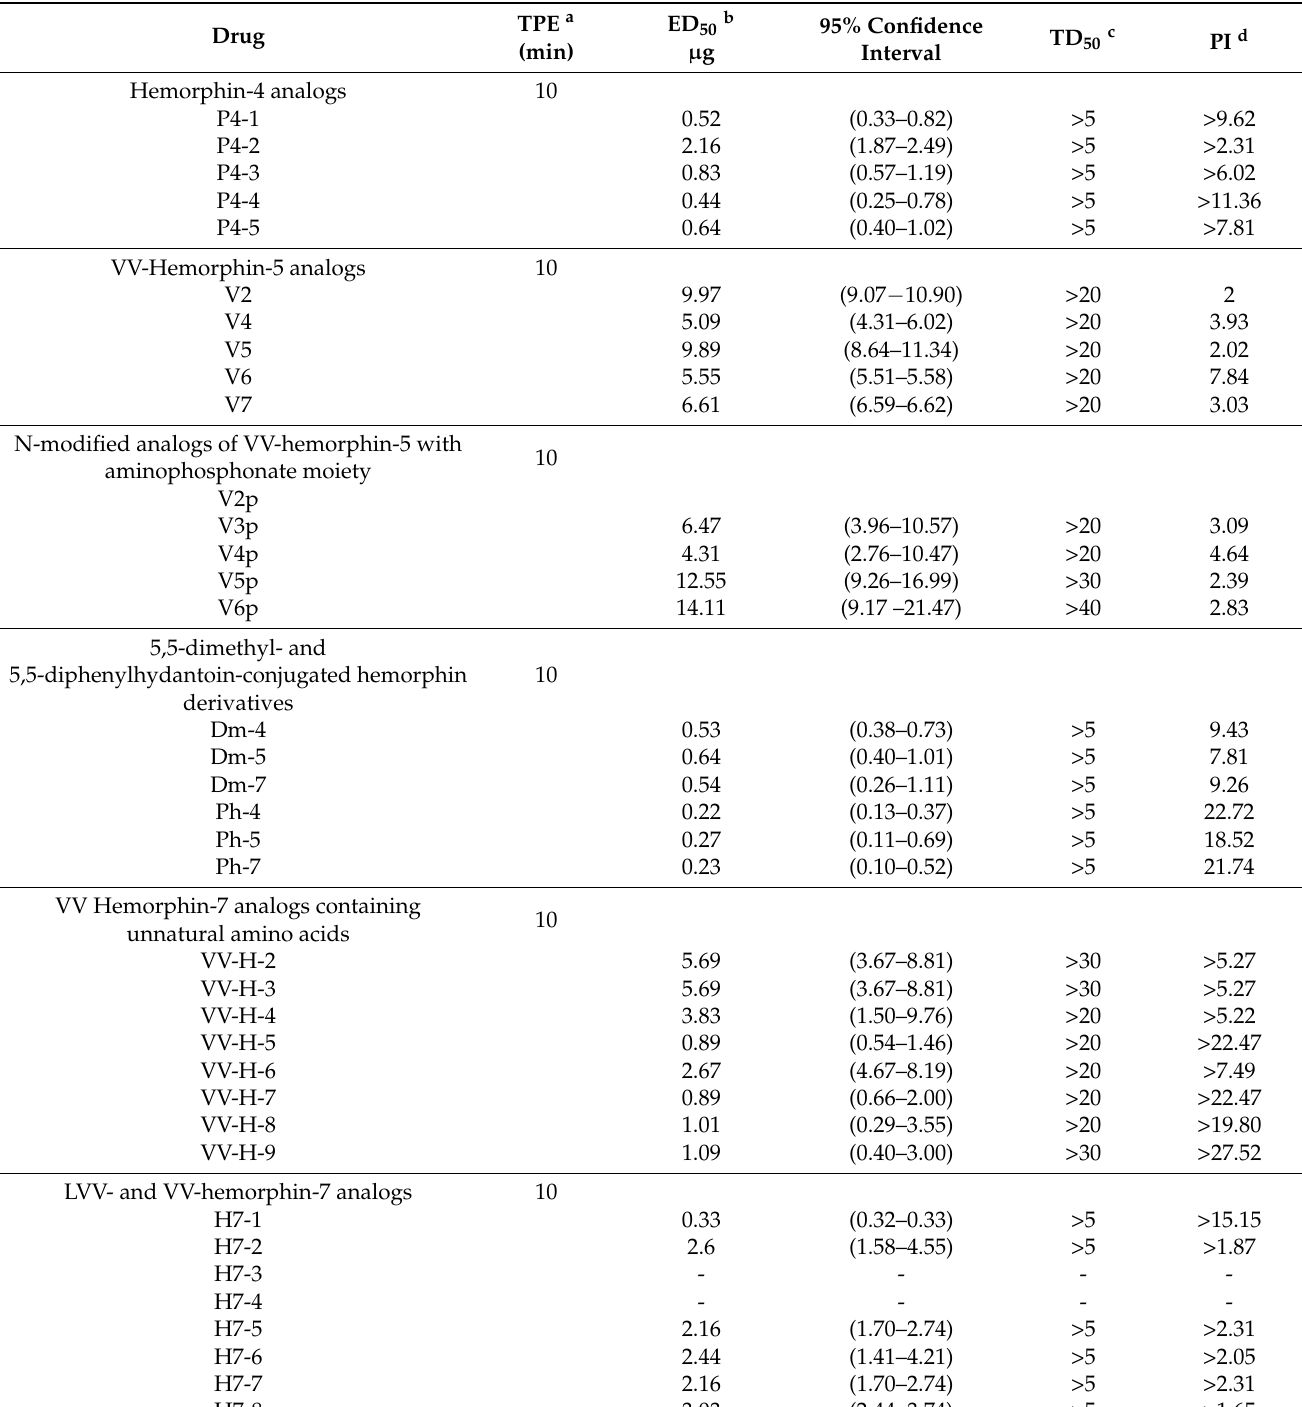
Table 3. Quantitative assessment of anticonvulsant activity of hemorphin peptides in the 6 Hz test in